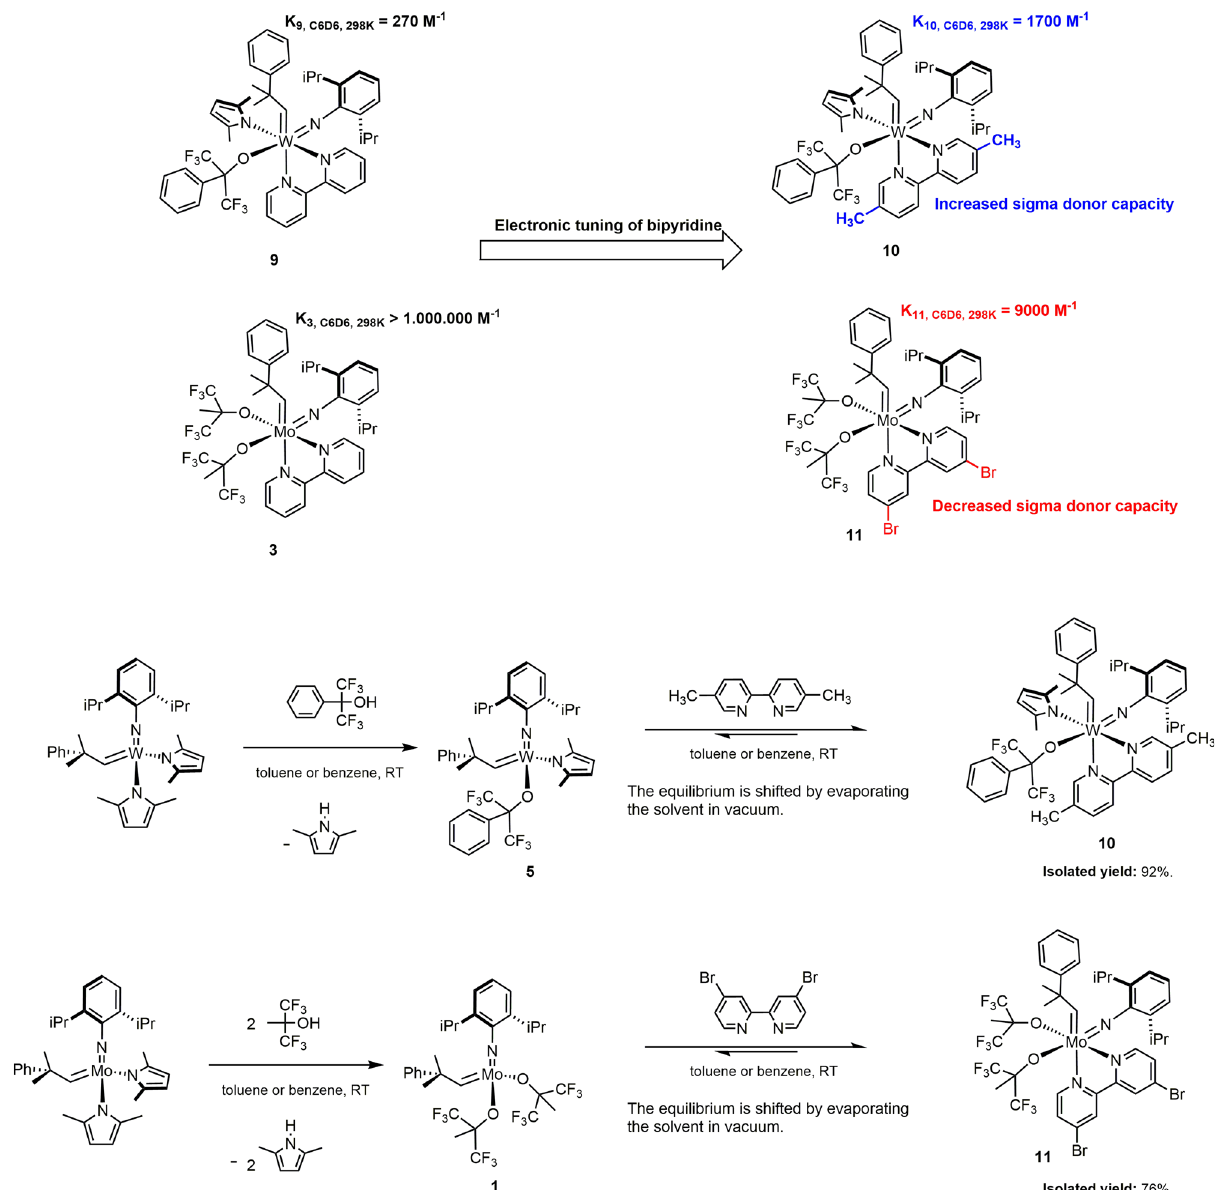
Fig. 10 Tuning of the stability constant of the 18-electron storage complexes via tuning the basicity of the Lewis base. Using Lewis bases substituted with electron-donating or electron-withdrawing groups can increase or decrease the stability constant of the adducts, respectively, hence extending the scope of the